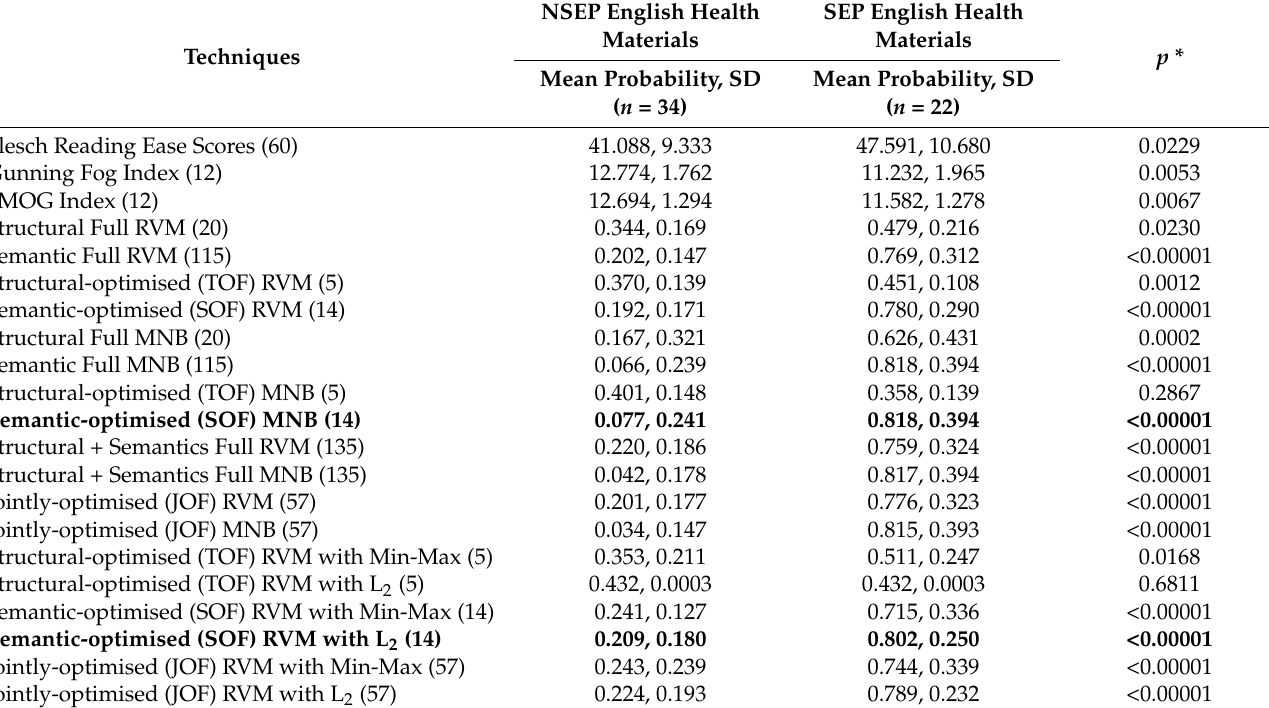
Table 3. Comparison of readability formula and MLC (RVM, MNB) output between symptom-error-prone (SEP) and non-symptom error-prone (NSEP) English texts (machine learning classifier outputs were assigned probabilities). Bold: bold values were